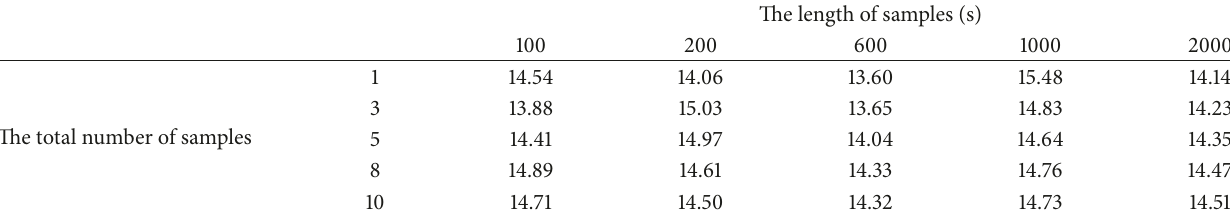
Table 5: The average of variance Ux displacement on tower top node 35# (mm).